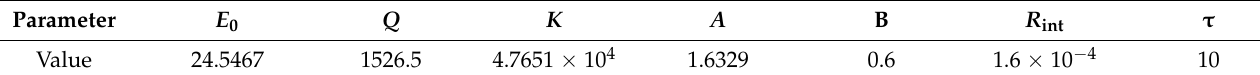
Table 1. Real Battery Parameters.